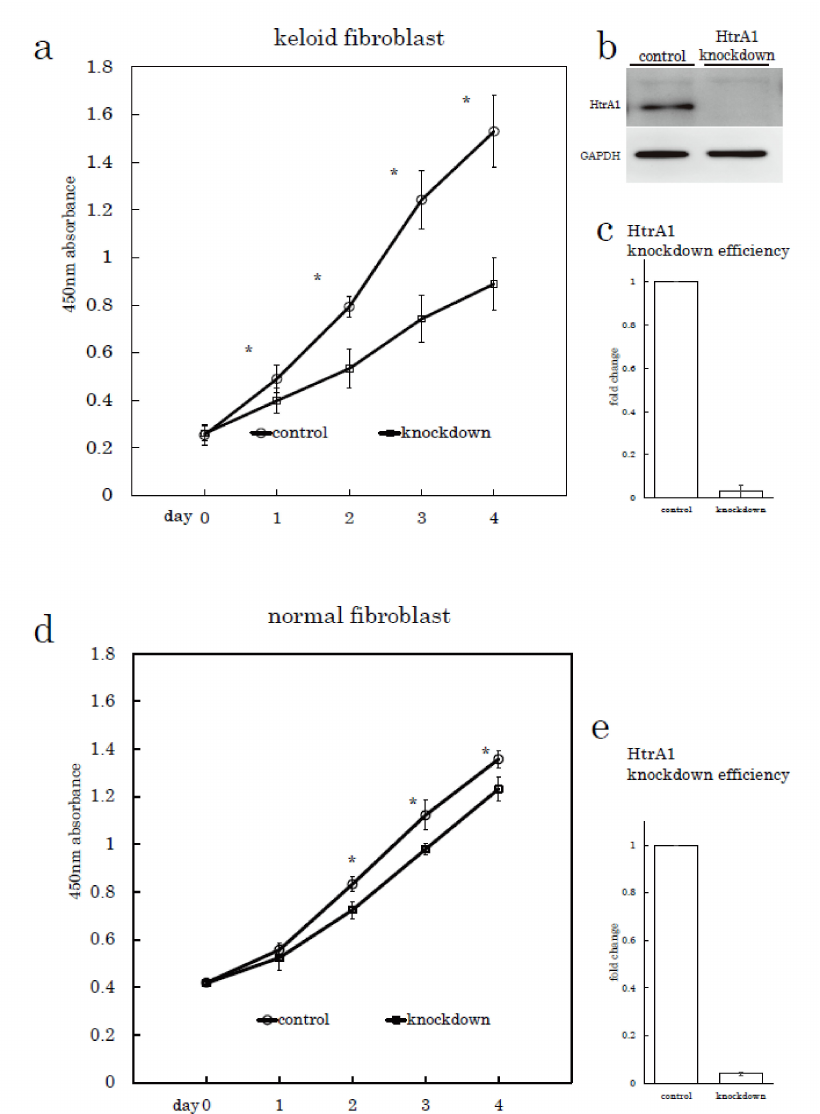
Figure 6. Proliferation rates of keloid fibroblasts and normal fibroblasts transfected with HtrA1 siRNA or control siRNA. Proliferation curves of keloid fibroblasts obtained from keloid sample No. 26 as shown in Table 1 ( a ), ( n = 3) and normal fibroblasts from sample No. 8 ( d ) transfected with HtrA1 siRNA (knockdown) or control siRNA (control). The efficiency of HtrA1 knockdown in keloid fibroblasts was determined using western blot analysis ( b ) and quantitative PCR ( c ), ( n = 3). The efficiency of HtrA1 knockdown in normal fibroblasts was similarly determined using quantitative PCR ( e ), n = 3. Cell proliferation was analysed using a colorimetric assay with a water-soluble tetrazolium salt as the substrate. Error bars represent standard deviations ( n = 3). * p <